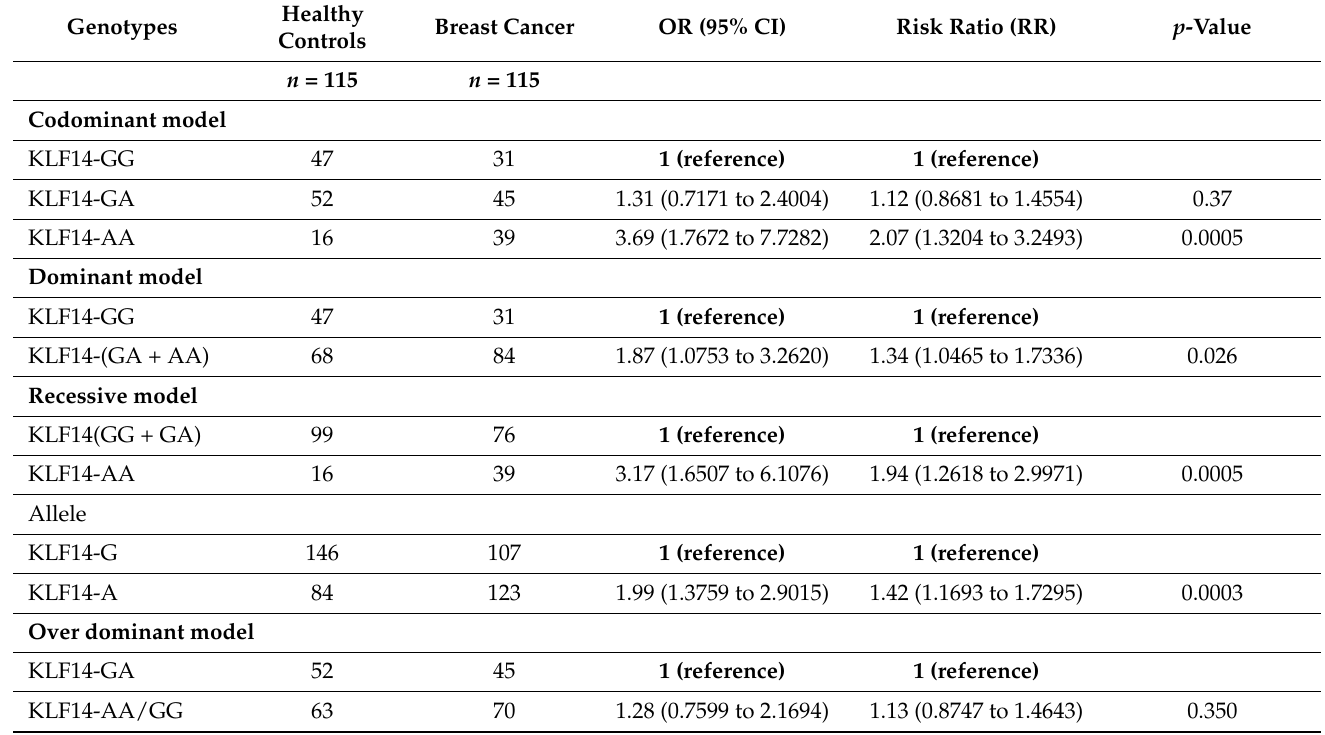
Table 6. Association of KLF 14 rs972283 G > A genotypes with breast cancer